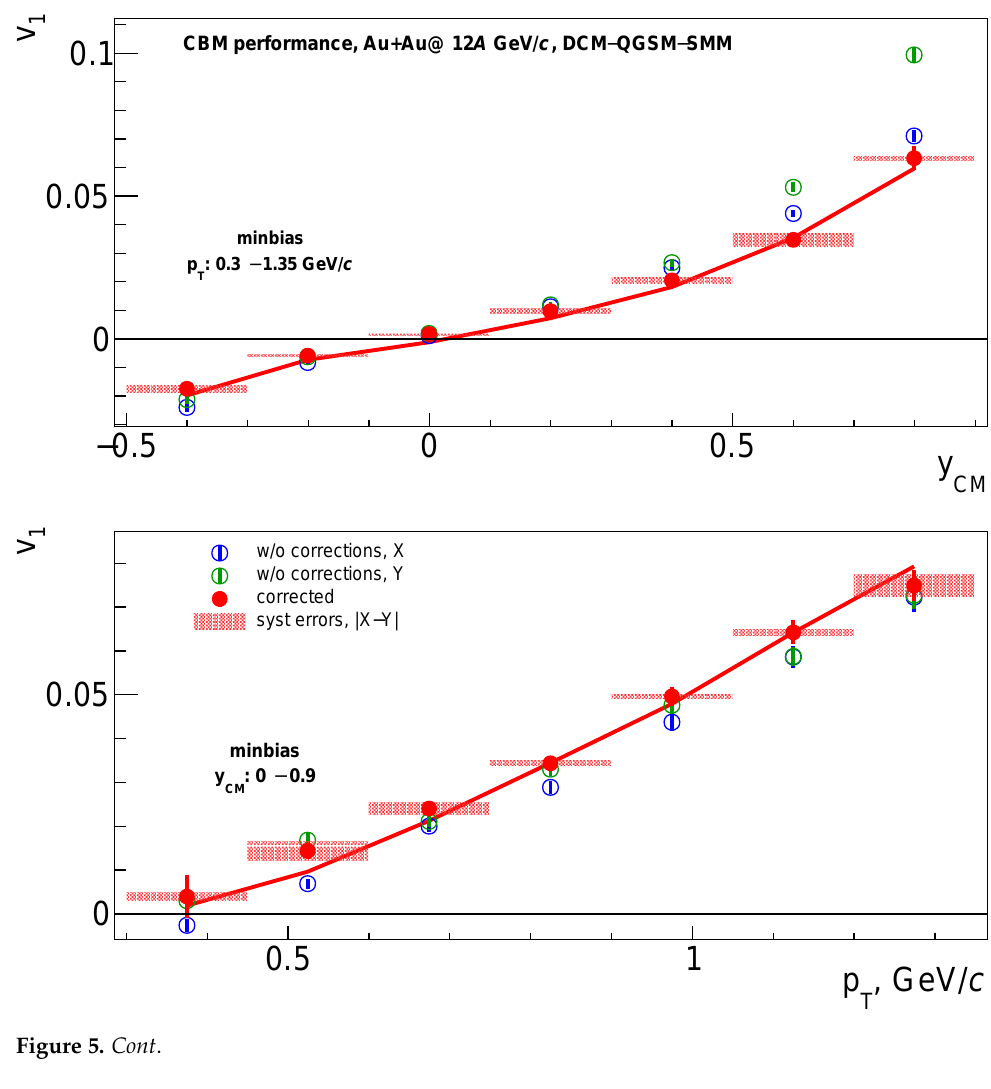
and true values of v 1 at small p T ∼ 0.5 GeV/ c , which requires further investigation with higher statistics. Figure 5 (bottom) illustrates v 1 dependence on centrality. The sign change of v 1 with centrality around 50% is reproduced. Peripheral collisions with centrality >70% are not considered in this analysis because of the very poor statistics of the produced Λ hyperons.